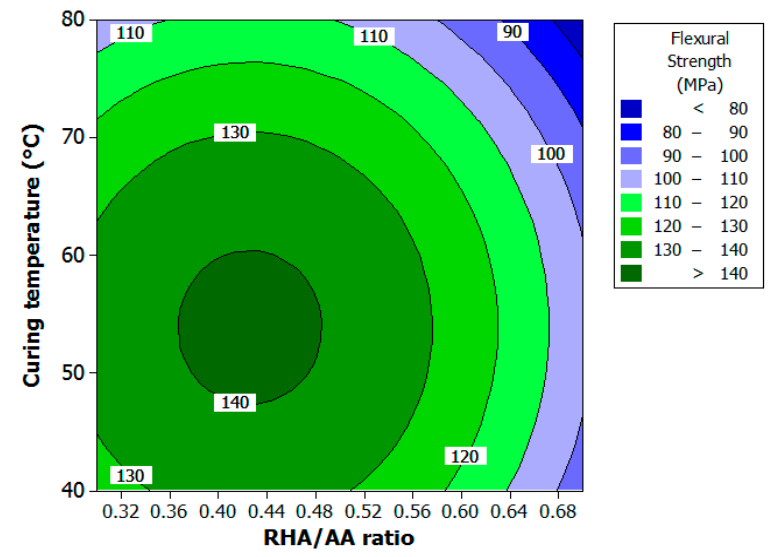
/ AA ratio for flexural